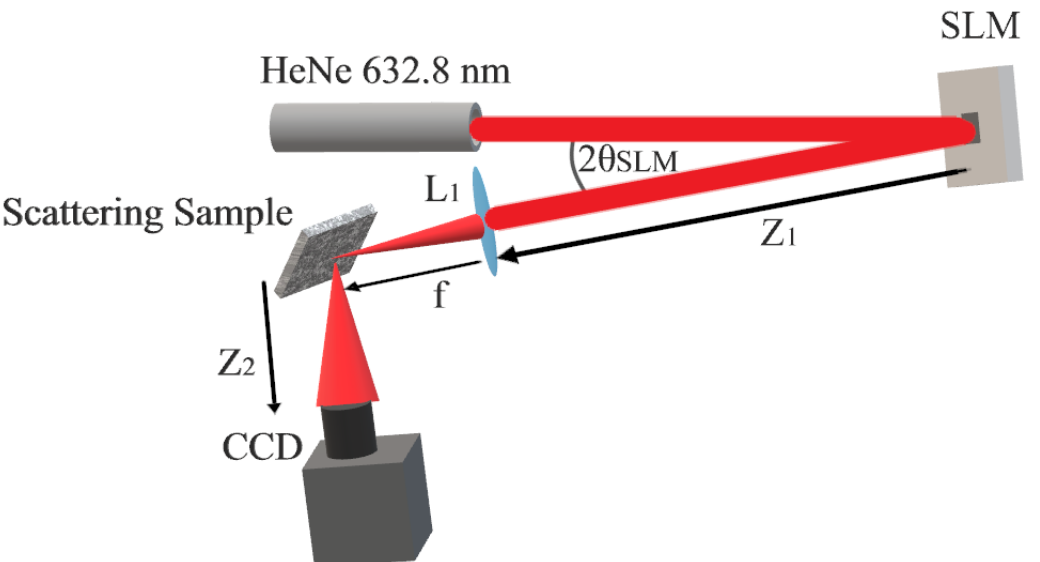
Figure 1. Simplified focal plane setup used in reflective inverse diffusion experiments. Polarized, collimated light is expanded and incident on the SLM at a slight angle. Light reflected from the SLM is focused by lens L 1 onto the scattering sample and reflected to the CCD. In the lab, the incident angle of the beam onto the SLM, denoted θ SLM , was 3.98° ± 0.01°, while Z 1 = 54 ± 0.5 cm, Z 2 = 40 ± 0.5 cm, f = 400